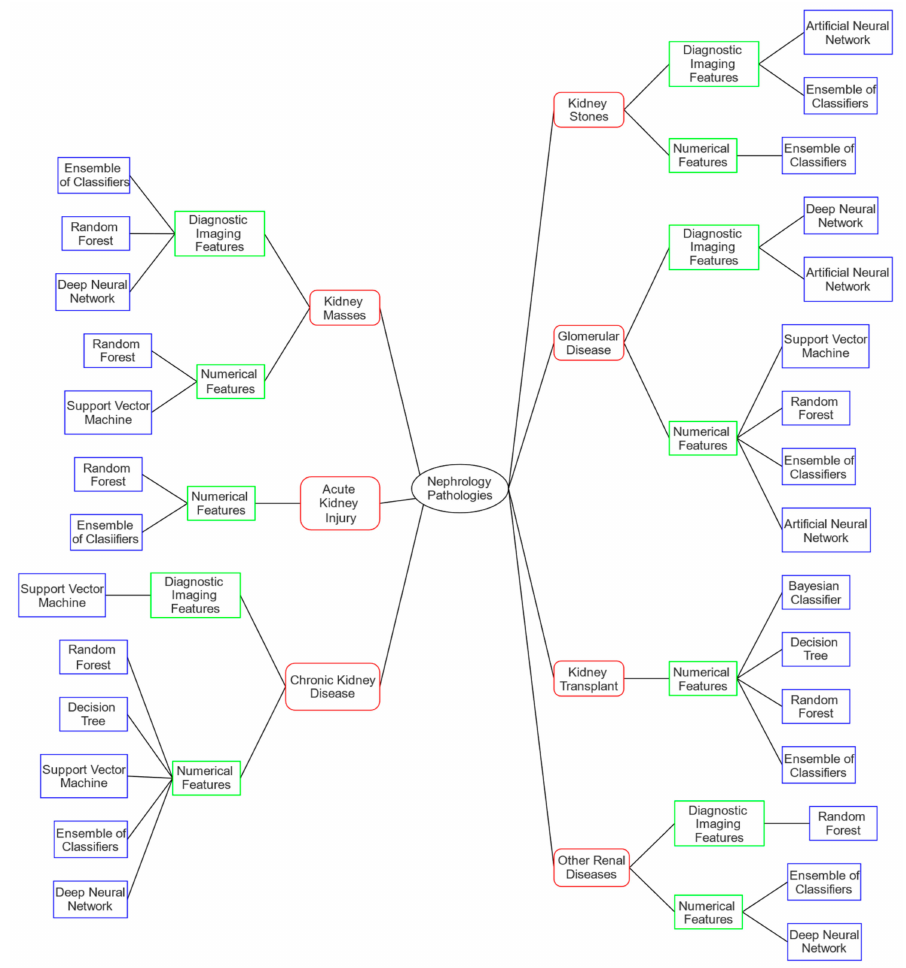
Figure 2. Scheme of pathologies with ML techniques applied according to the type of dataset available. Kidney disease addressed in red; type of available data in green; ML technique used in